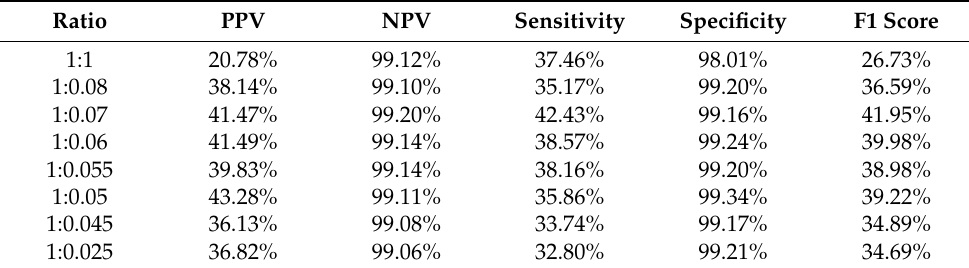
Table 3. Performance evaluation for the SMOTE ratio. The highest positive predictive value was observed at a ratio of 1:0.05 and highest negative predictive value was observed at a ratio of 1:0.07. The highest sensitivity was observed at a ratio of 1:0.07 and highest specificity was observed at a ratio of 1:0.05. The highest F1 score was observed at a ratio of 1:0.07.